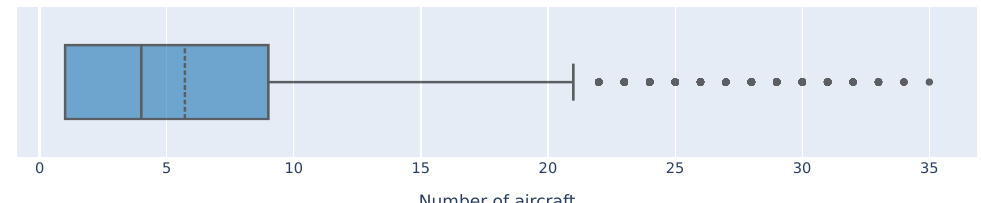
Figure 5. Box plot of the number of aircraft simultaneously affected by RFI in AoI-1.